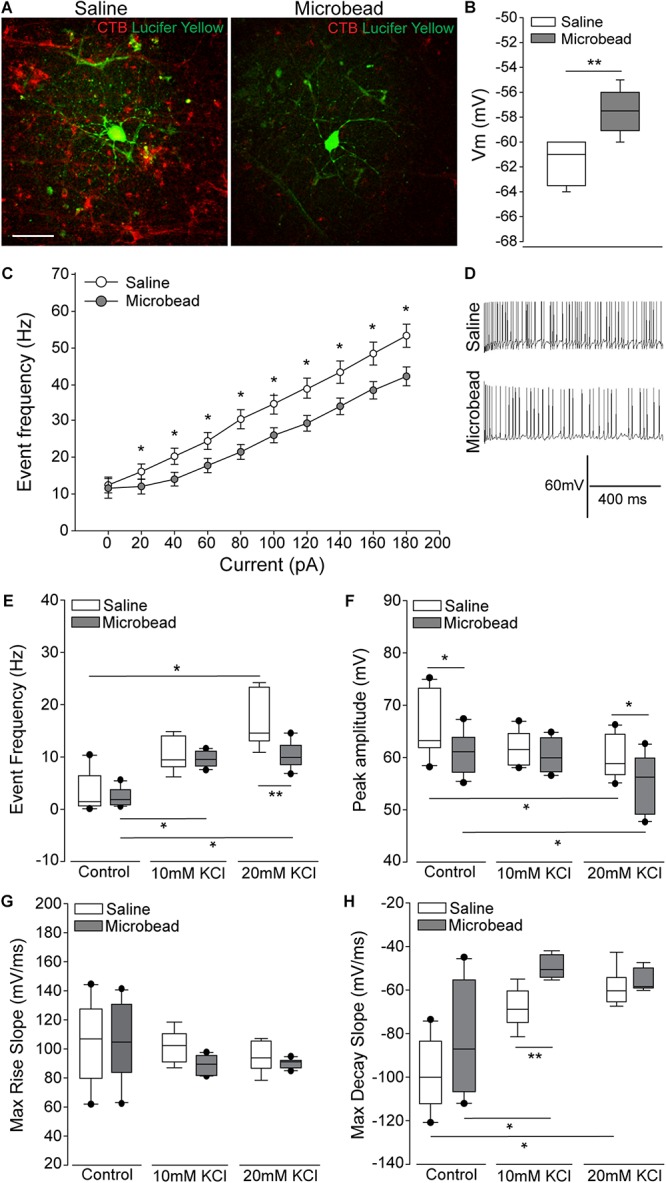
Retinal ganglion cells (RGCs) with deficient axon transport exhibit decreases in induced spiking frequency that result from delayed repolarization. (A) Representative confocal micrographs of RGCs in whole retina following electrophysiological recordings from saline- (left) and microbead-injected (right) eyes. RGCs are CTB-traced (red) and filled with lucifer yellow (green). Scale bar = 50 μM. (B) Mean resting membrane potential (Vm) of RGCs from saline- (white) and microbead-injected (gray) retina. ∗∗p < 0.001 and error bars represent SEM. n(saline) = 27 cells (from 14 retina), n(microbead) = 34 cells (from 11 retina). (C) Frequency of spiking of RGCs from saline- (white) and microbead-injected (gray) retina following current stimulation in 20 pA steps for 1 s from 0 to 180 pA. Mean event frequency (Hz) is displayed at each current step. ∗p < 0.05. n(saline) = 26 cells (from 14 retina), n(microbead) = 26 cells (from 11 retina). (D) Representative traces of spiking with 180 pA stimulation. (E) Frequency of spontaneous spiking of RGCs from saline- (white) and microbead-injected (gray) retina in control bath, or bath containing 10 or 20 mM KCl. Data are displayed as mean event frequency (Hz) across cells for each condition. ∗p < 0.05, ∗∗p < 0.005. n(saline) = 12, n(microbead) = 10, n(saline 10) = 9, n(microbead 10) = 12, n(saline 20) = 9, n(microbead 20) = 11 (from n = 5 retina/condition). (F) Peak amplitude of spontaneous spiking of RGCs. Data are displayed as mean peak amplitude (mV) across cells for each condition. ∗p < 0.05. n(saline) = 11, n(microbead) = 11, n(saline 10) = 10, n(microbead 10) = 12, n(saline 20) = 11, n(microbead 20) = 17 (from n = 5 retina/condition). (G) Max rise slope of spontaneous spiking of RGCs. Data are displayed as mean max rise slope (mV/ms) across cells for each condition. n(saline) = 14, n(microbead) = 13, n(saline 10) = 9, n(microbead 10) = 10, n(saline 20) = 9, n(microbead 20) = 10 (from n = 5 retina/condition). (H) Max decay slope of spontaneous spiking of RGCs. Data are displayed as mean max decay slope (mV/ms) across cells for each condition. ∗p < 0.05, ∗∗p < 0.001. n(saline) = 10, n(microbead) = 12, n(saline 10) = 9, n(microbead 10) = 9, n(saline 20) = 9, n(microbead 20) = 9 (from n = 5 retina/condition).